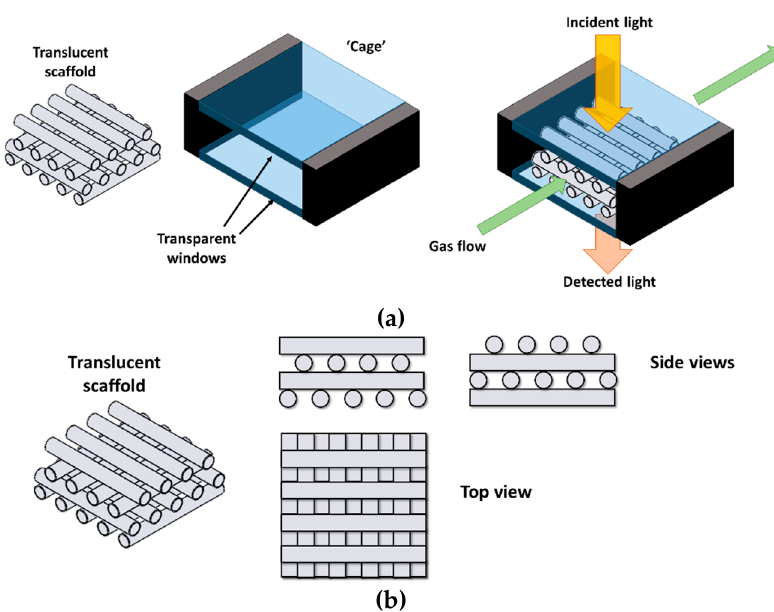
Figure 1. ( a ) Scheme for optical sensing device; ( b ) top and side views of a translucent scaffold .